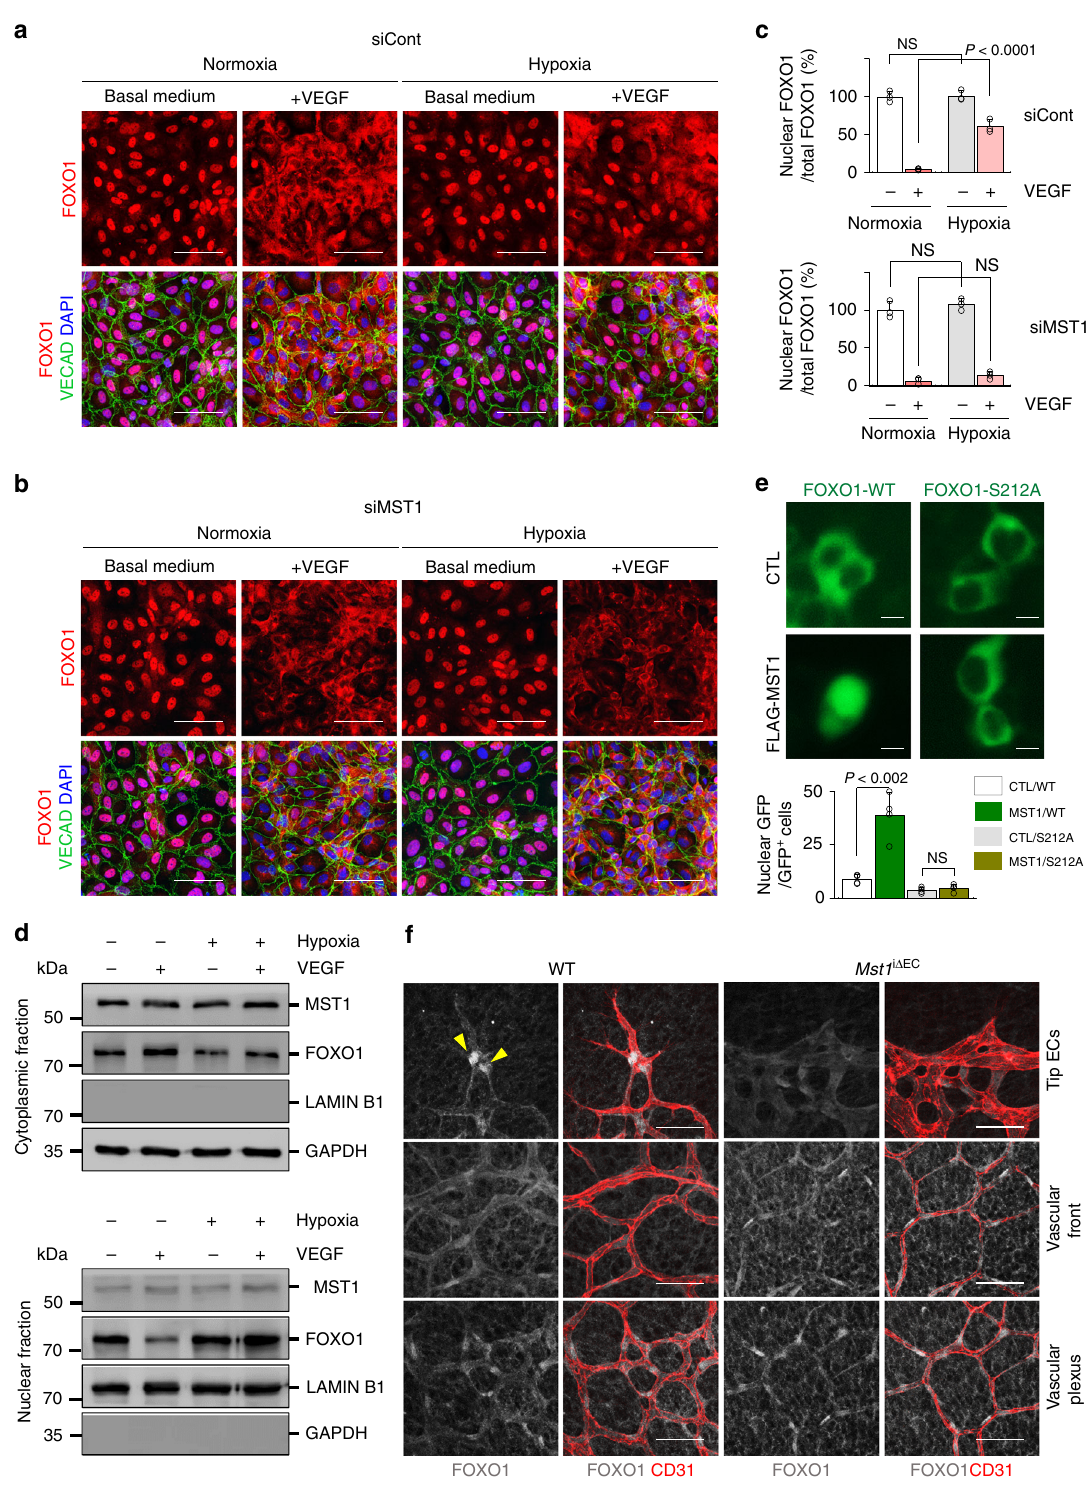
neovascularization and contributes to establishing endothelial polarity in